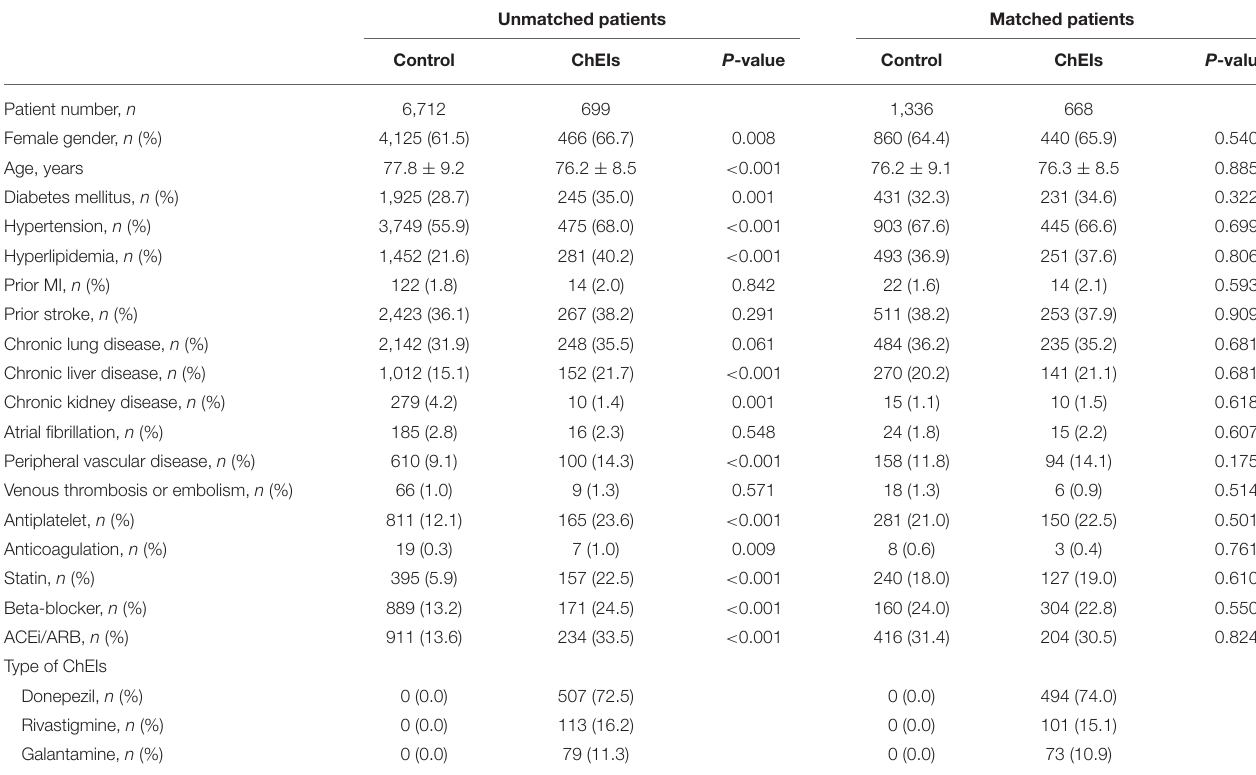
TABLE 1 | Baseline characteristics before and after propensity score matching.